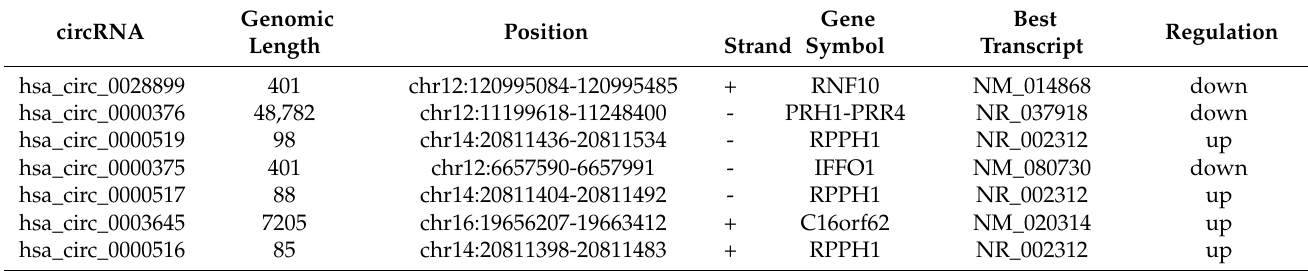
Table 1. Basic characteristics of seven differently expressed